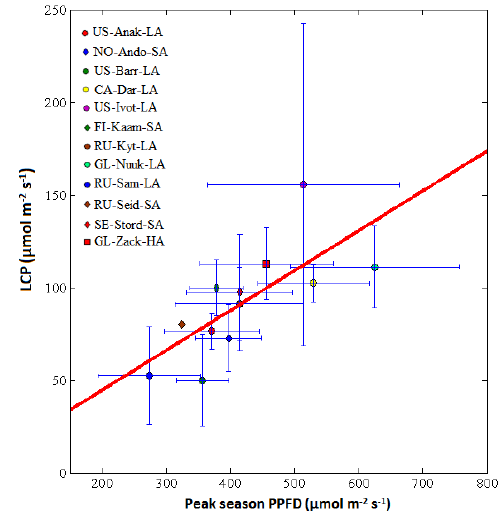
Figure 6. Averaged peak season PPFD (light) control on light com- pensation point (LCP) parameter. r 2 = 0 . 5, p = 0 .